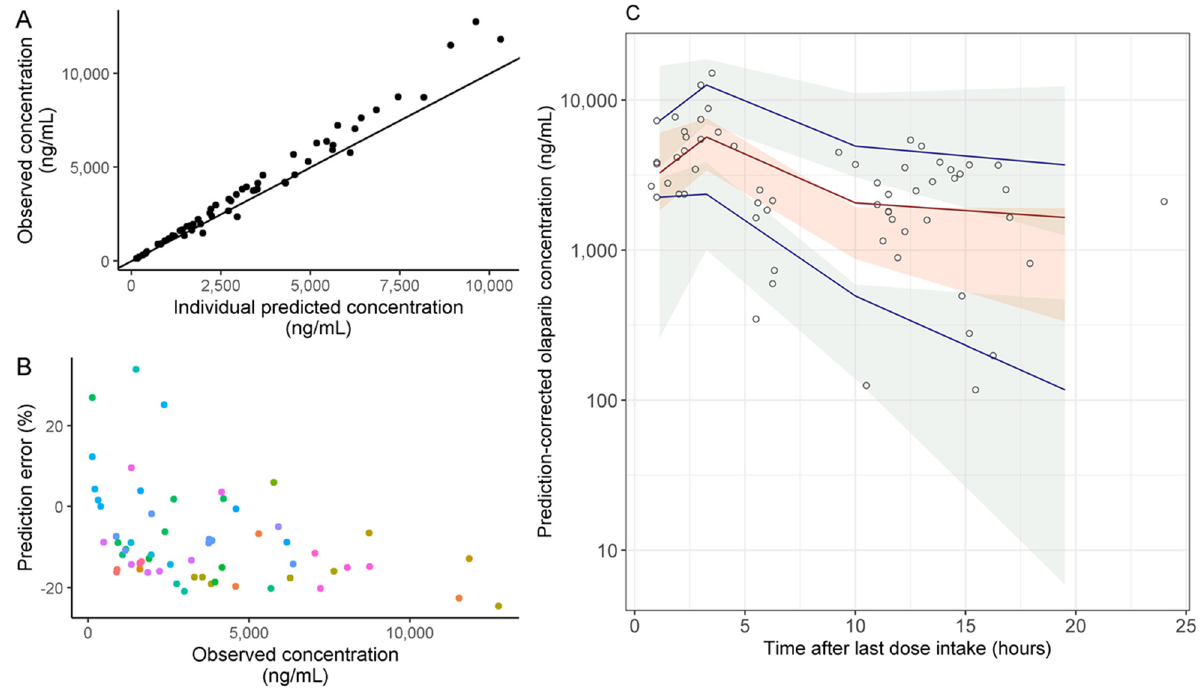
Figure 2. Evaluation of the predictive performance of the population PK model. ( A ) Observed vs. individual predicted olaparib concentrations. Solid line represents the identity line (y = x) ( B ) Prediction error (PE) vs. observed concentrations. ( C ) Prediction-corrected visual predictive check (pcVPC) for olaparib. pcVPC obtained by N = 1000 simulations of the original dataset with the mean parameters (fixed and random effects). The shaded areas represent the 95% confidence intervals around the 5th, 50th (median) and 95th percentile of the simulated concentrations, the lines represent the 5th, 50th (median) and 95th percentile of the observed concentrations and the circles represent the observed concentrations.